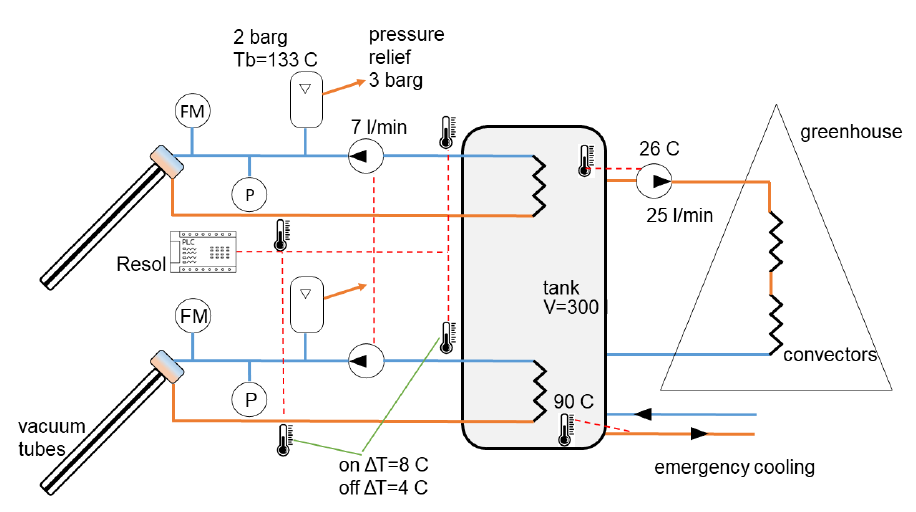
Figure 2. Schematic description of the vacuum tube